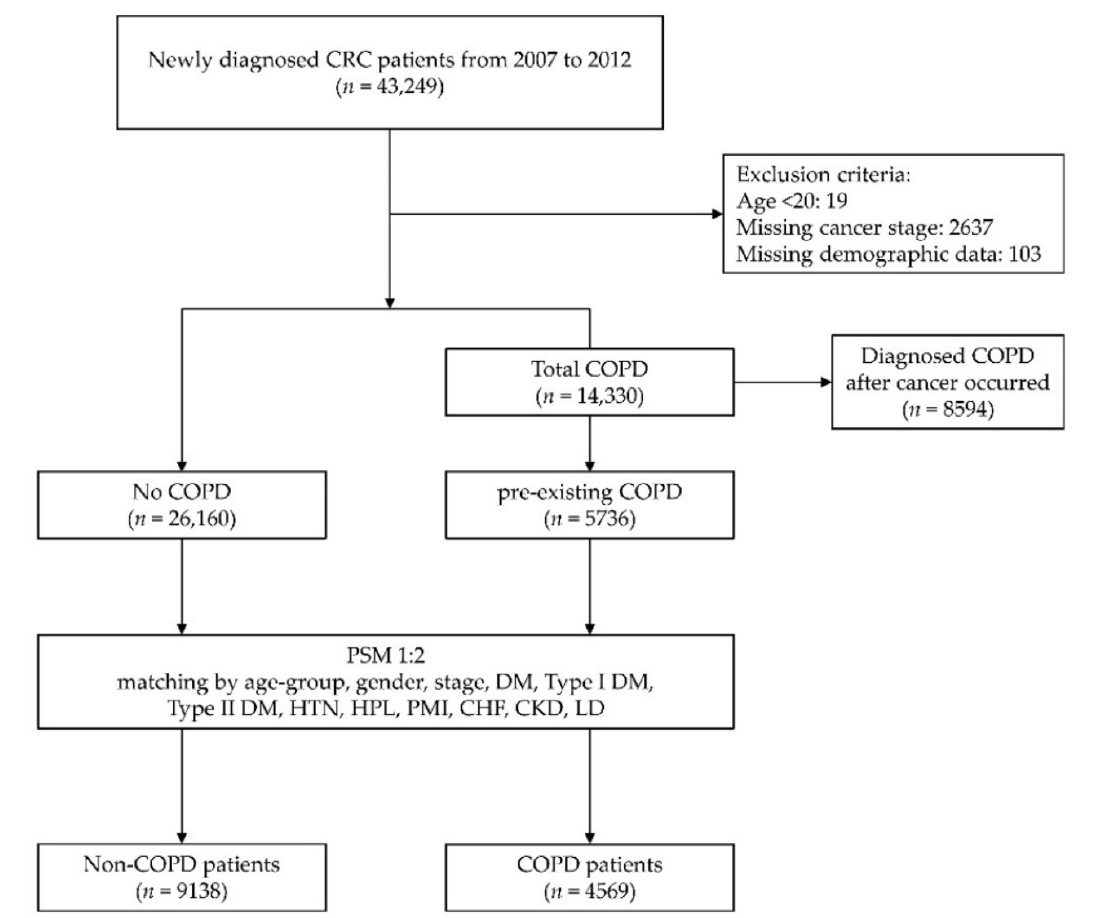
Figure 1. Flowchart of the patient enrollment process of this cohort study and variables used in propensity score matching. Abbreviations: CRC, colorectal cancer; COPD, chronic obstructive pulmonary disease; PSM, propensity score matching; DM, diabetes mellitus; HTN, hypertension; HPL, hyperlipidemia; PMI, prior myocardial infarction; CHF, congestive heart failure; CKD, chronic kidney disease; LD, liver disease. Table 1. Clinical characteristics before and after PSM of study patients.